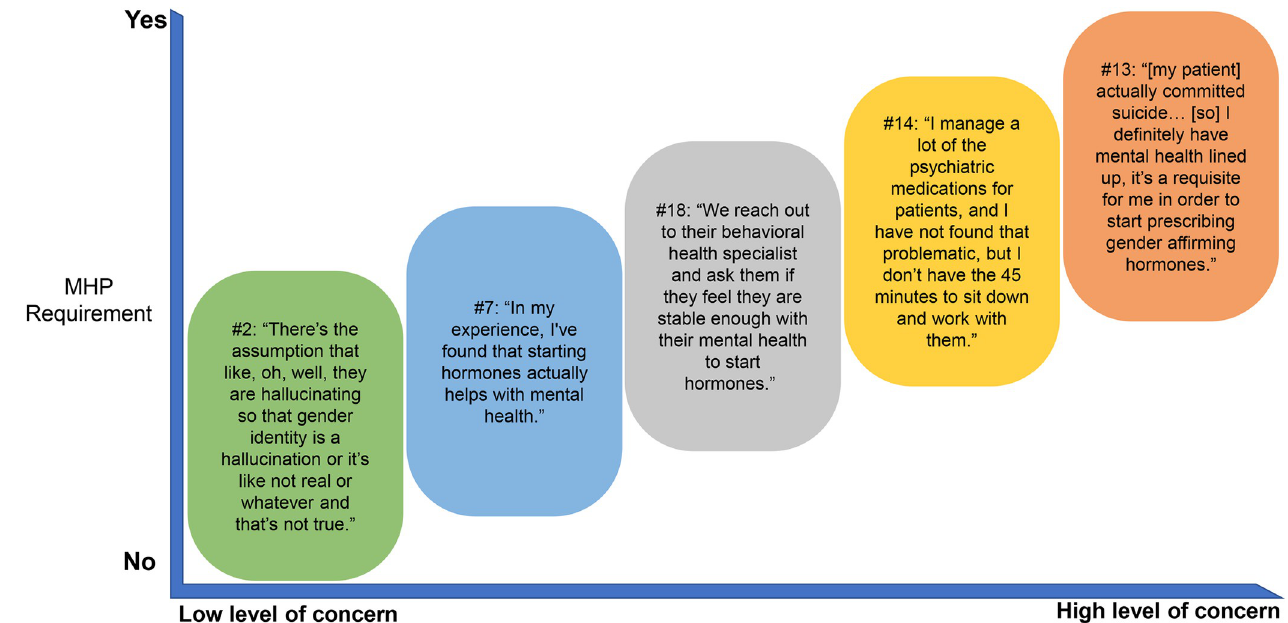
Fig 4. Providers’ concern about mental illness and effects of GAH on mental health. GAH, gender affirming hormones; MHP, mental health